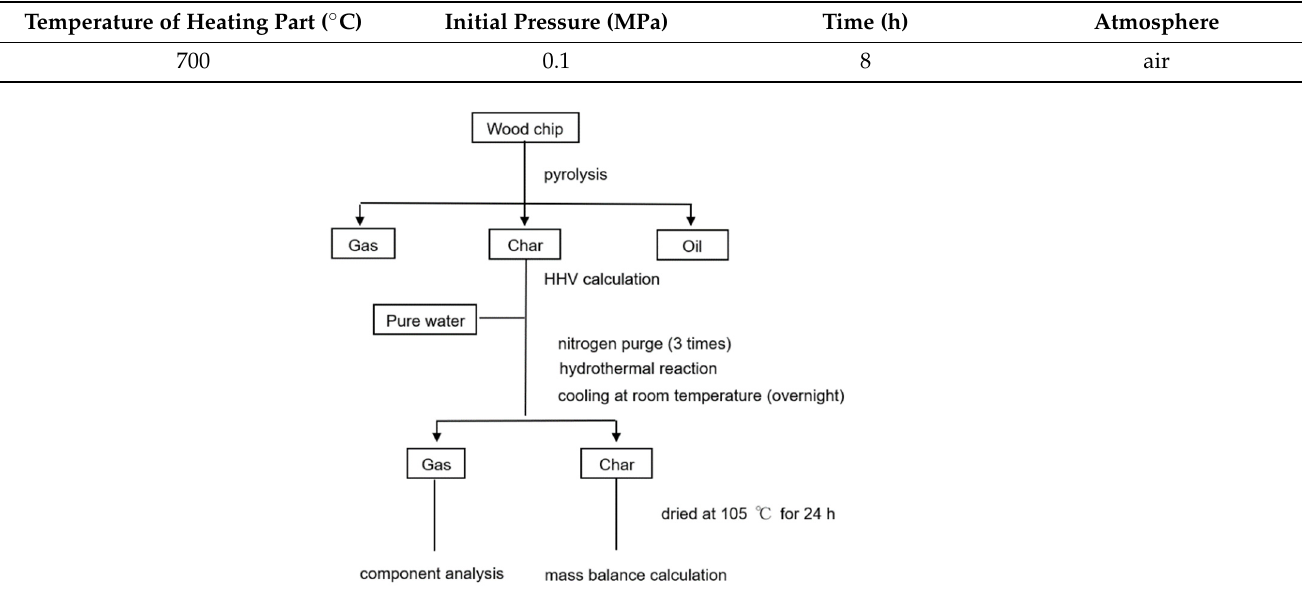
Figure 4. Experimental flow of combined experiment. Table 1. Experimental conditions for HTG (group 1).